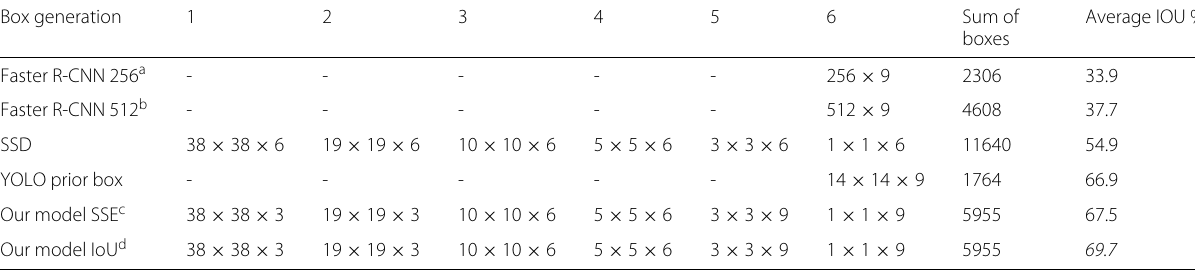
Table 1 Network configuration parameters